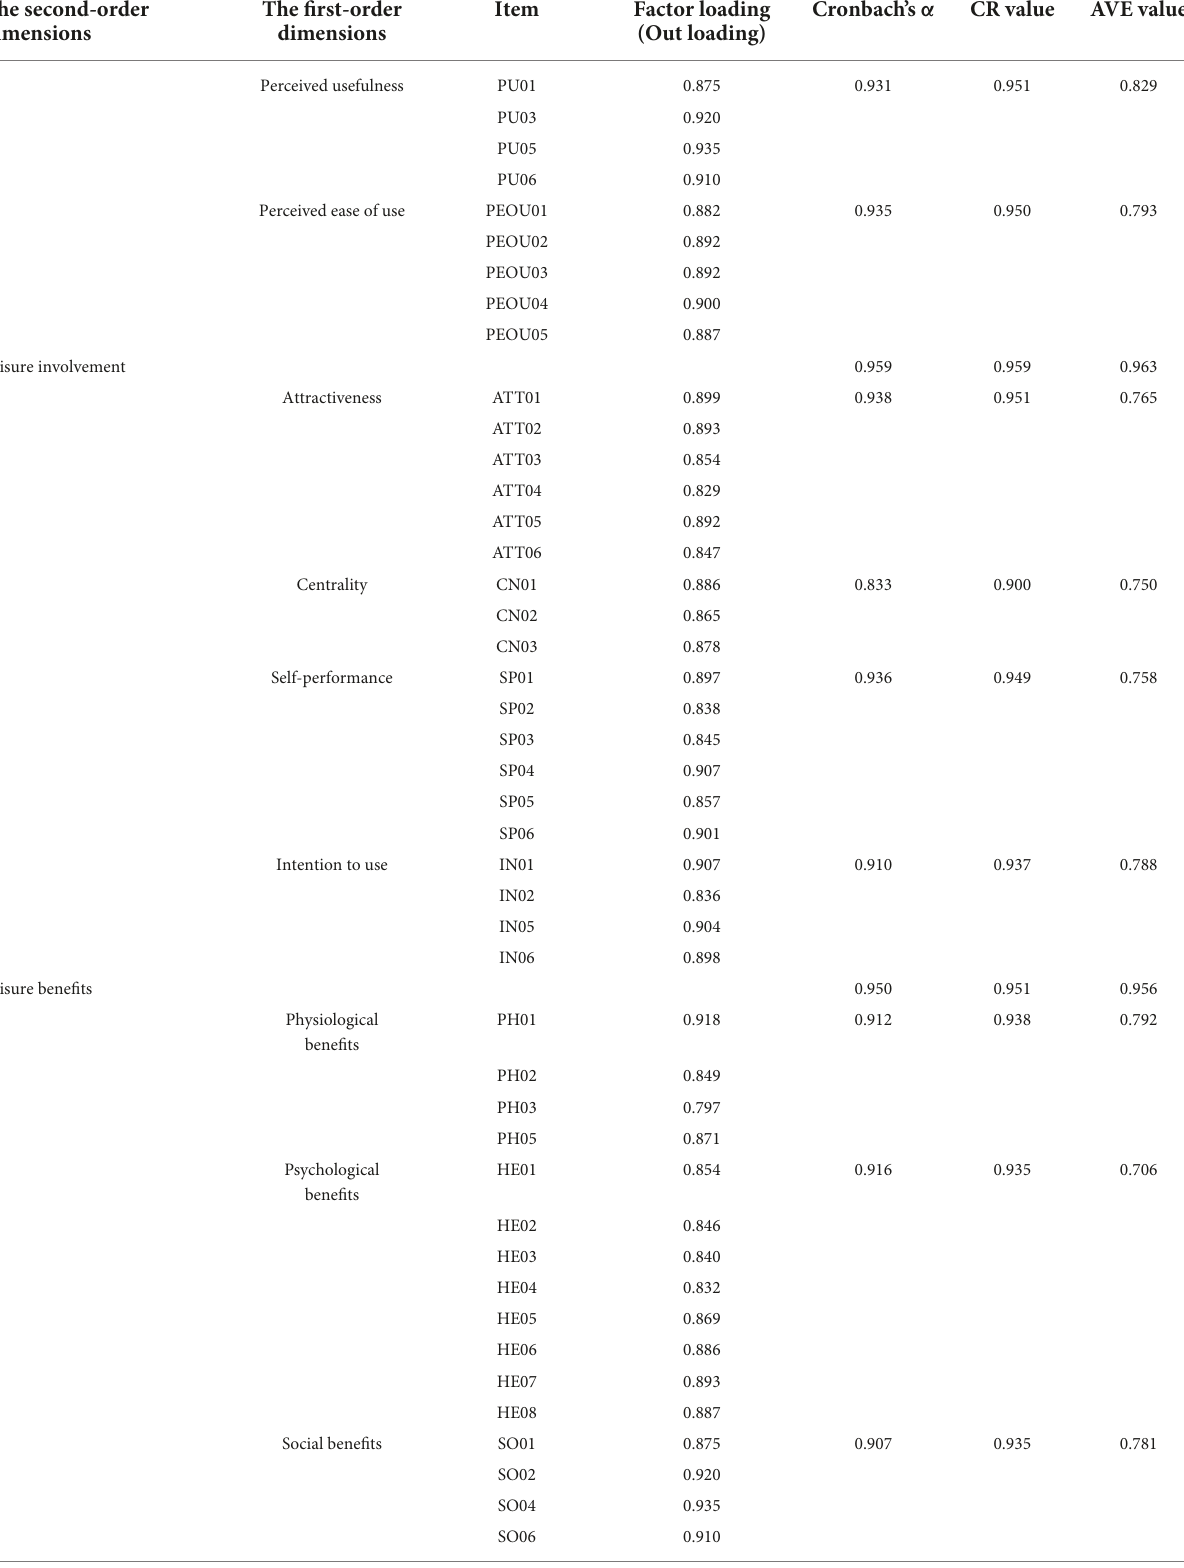
TABLE 2 Measurement model parameter